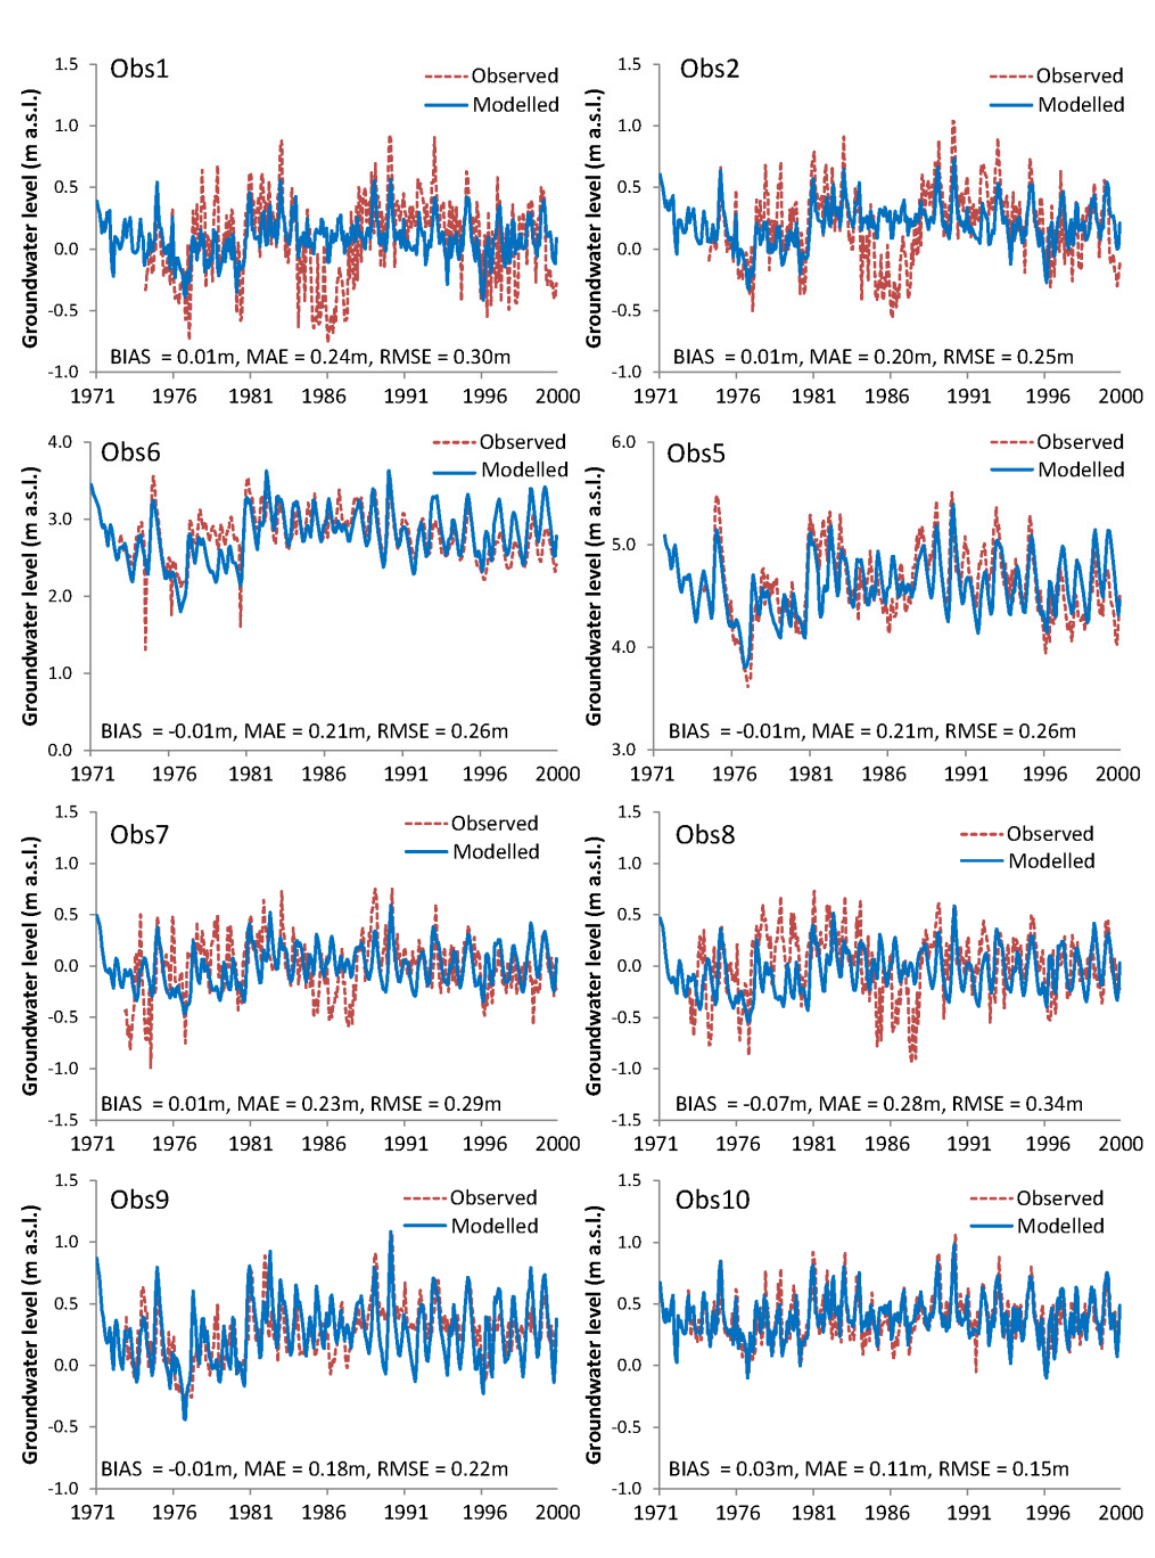
Figure 7. Comparisons between simulated (solid line) and observed (dashed line) groundwater levels for the selected observation wells, 1971–2000. Locations of observation wells (Obs) are shown in Figure